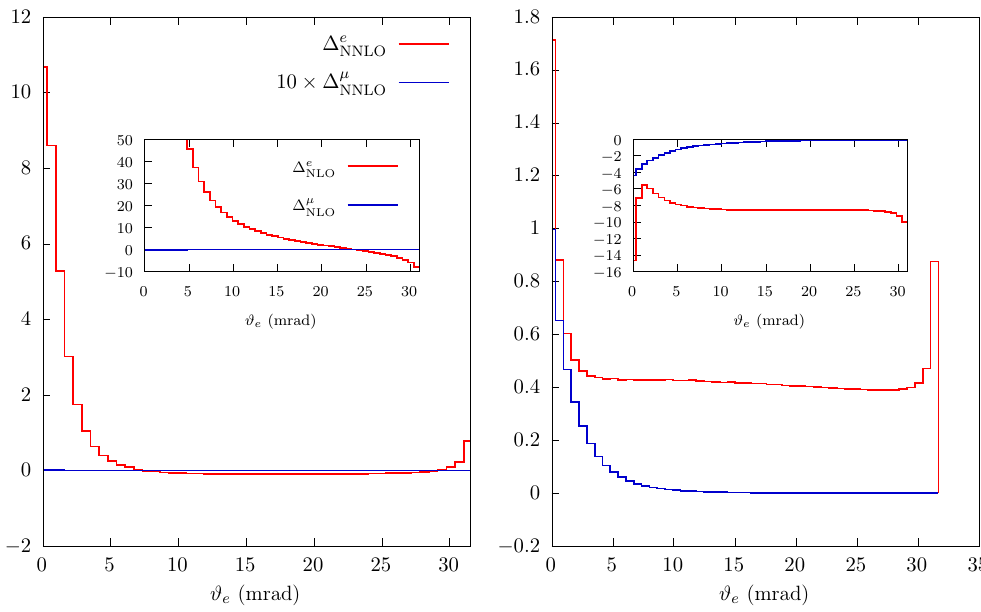
Figure 3 . Red histograms: NNLO corrections, according to eq. (4.2), along the electron line, for the (cid:22) (cid:6) e (cid:0) (cid:22) (cid:6) e (cid:0) processes, as a function of the electron scattering angle in the laboratory frame, ! # e ; blue histogram: 10 NNLO corrections along the muon line. Left panel: di(cid:11)erential distribution (cid:2) in the presence of acceptance cuts only (Setup 1); right panel: the same as in the left panel with the additional acoplanarity cut of Setup 2. The insets report the NLO corrections, according to eq. (4.3); the blue line represents directly eq. (4.3) without any multiplicative